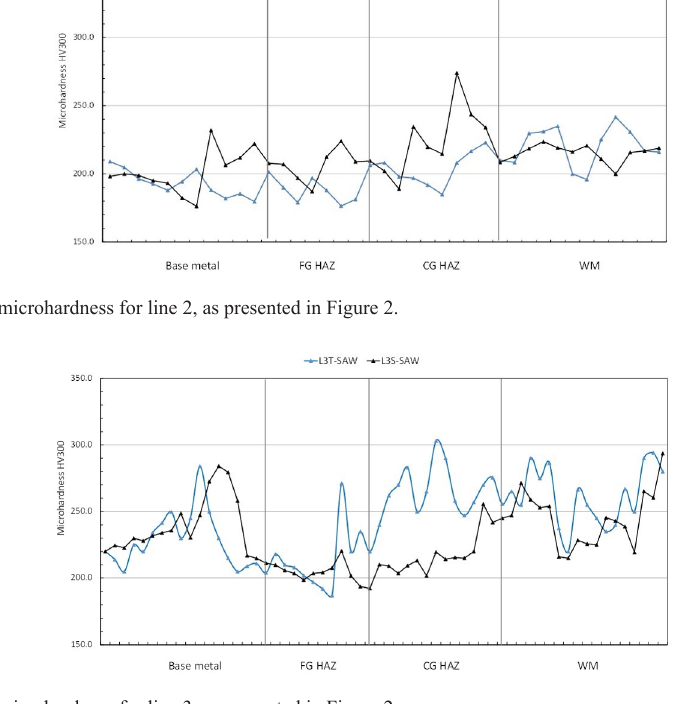
Figure 15: Results of microhardness for line 3, as presented in Figure